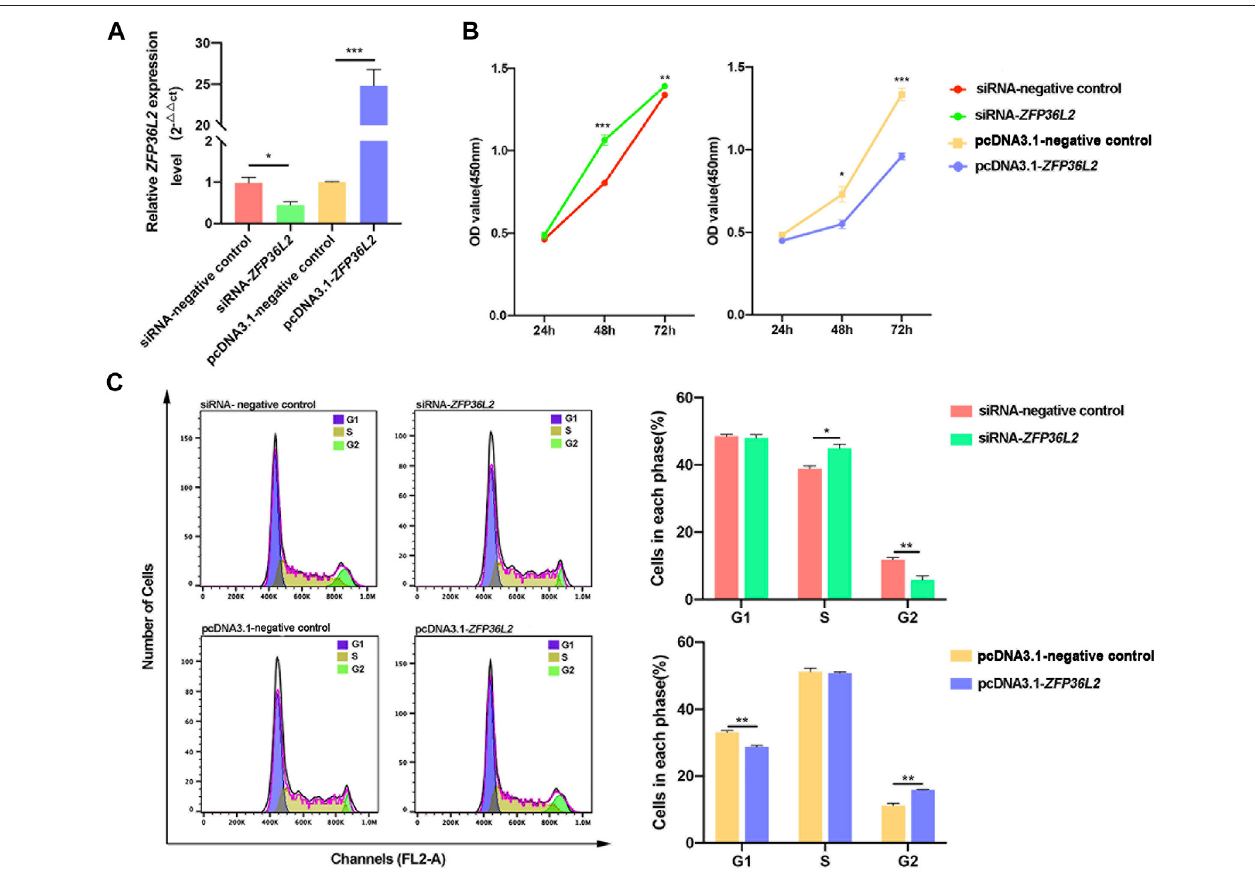
FIGURE 4 | (A) RT-qPCR analysis of the expression level of ZFP36L2 after knockdown or overexpression in the GMSM-K cell line. (B) Cell proliferation after knockdown or overexpression of ZFP36L2 in the GMSM-K cell line. (C) Percentage of cells in each cell cycle after knockdown or overexpression of ZFP36L2 in the GMSM-K cell line. Data is shown as the mean ± SEM. * p < .05; ** p < .01; *** p <